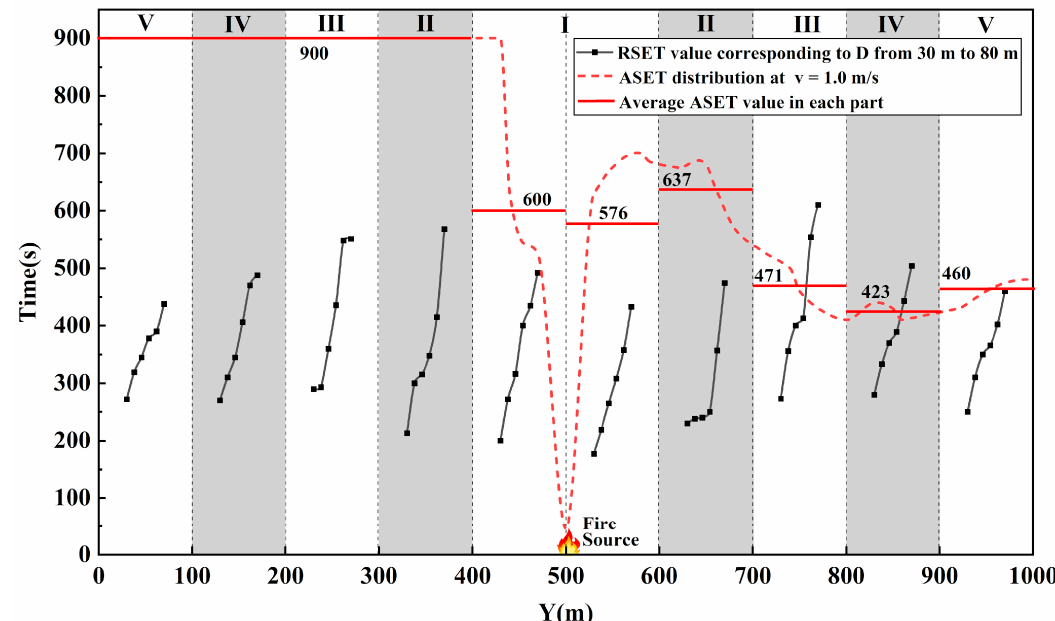
Figure 10. ASET compared with RSET corresponding to different D under the condition of v = 1.0 m/s.